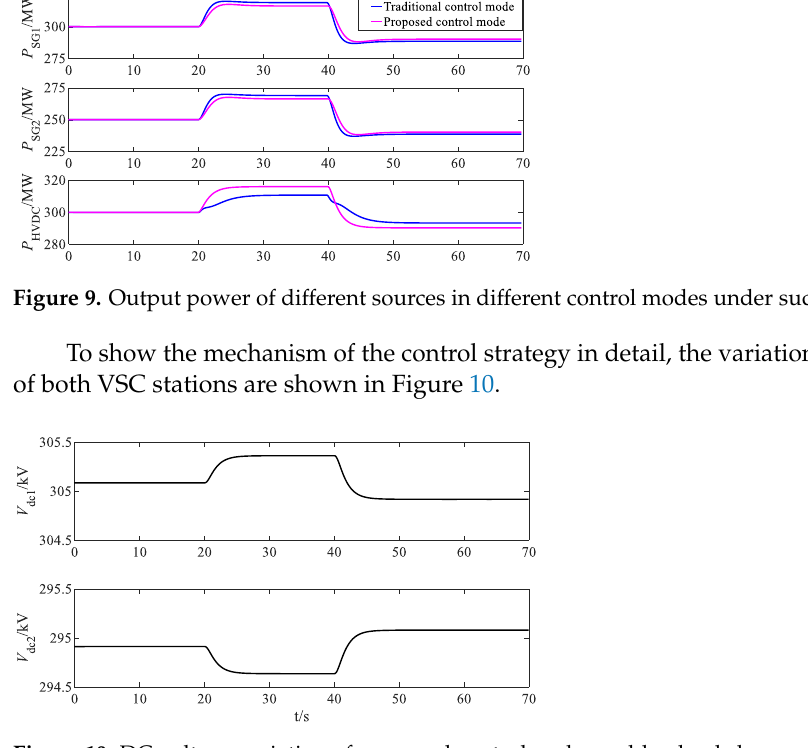
Figure 8. Frequency variation in different control modes under sudden load changes.